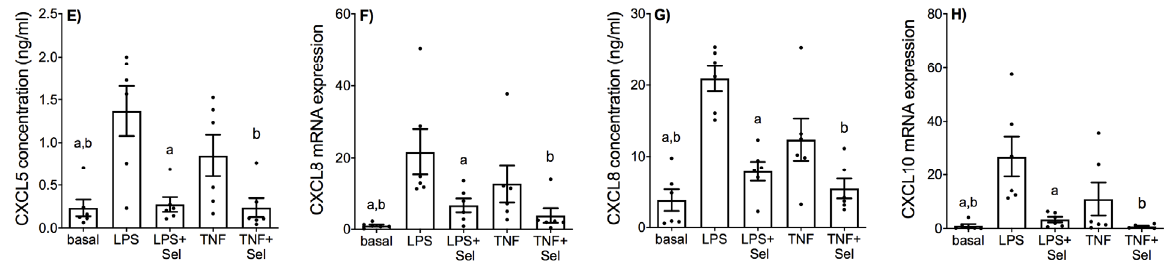
Figure 9. Effect of selenium on CXCL chemokine expression in SAT from pregnant women. SAT was incubated with or without 10 µ M sodium selenite (Sel) for 1 h and then stimulated with 10 µ g/mL LPS or 10 ng/mL TNF- α for a further 20 h ( n = 6 patients). ( A , C , D , F , H ) CXCL1, CXCL2, CXCL5, CXCL8 and CXCL10 mRNA expression was analysed by RT-qPCR and fold change was calculated relative to basal expression. ( B , E , G ) The concentration of CXCL1, CXCL5 and CXCL8 in the conditioned media was assayed by ELISA. For all graphs, individual data points represent six independent experiments and are displayed as mean ± SEM. a p ≤ 0.05 vs. LPS, b p ≤ 0.05 vs. TNF; repeated measures one-way